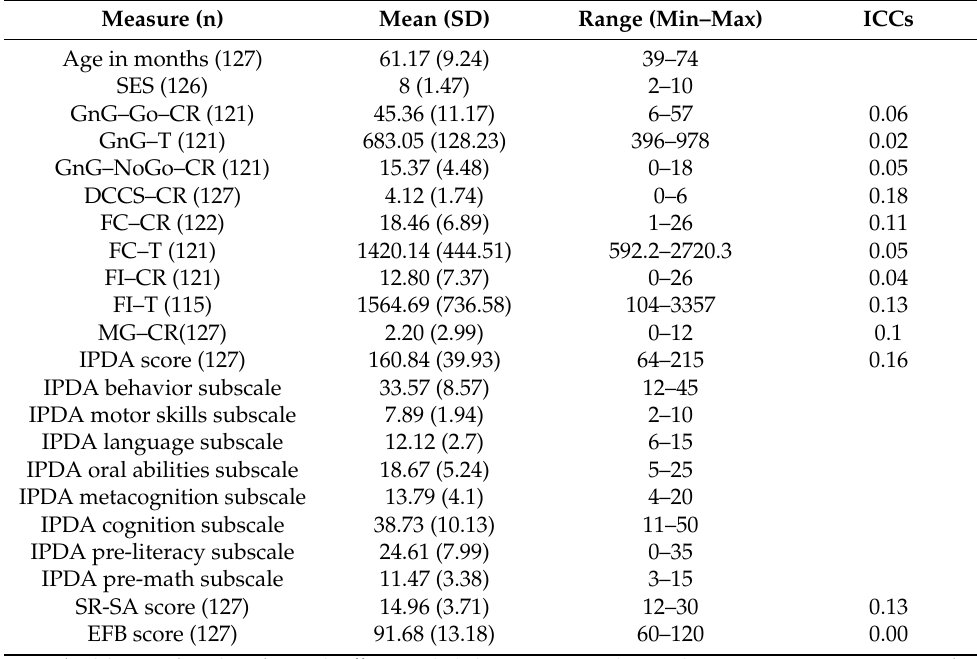
Table 1. Descriptive statistics of age, socio-economic status the scores at the EF tests, the learning prerequisites, the behavioral questionnaires and